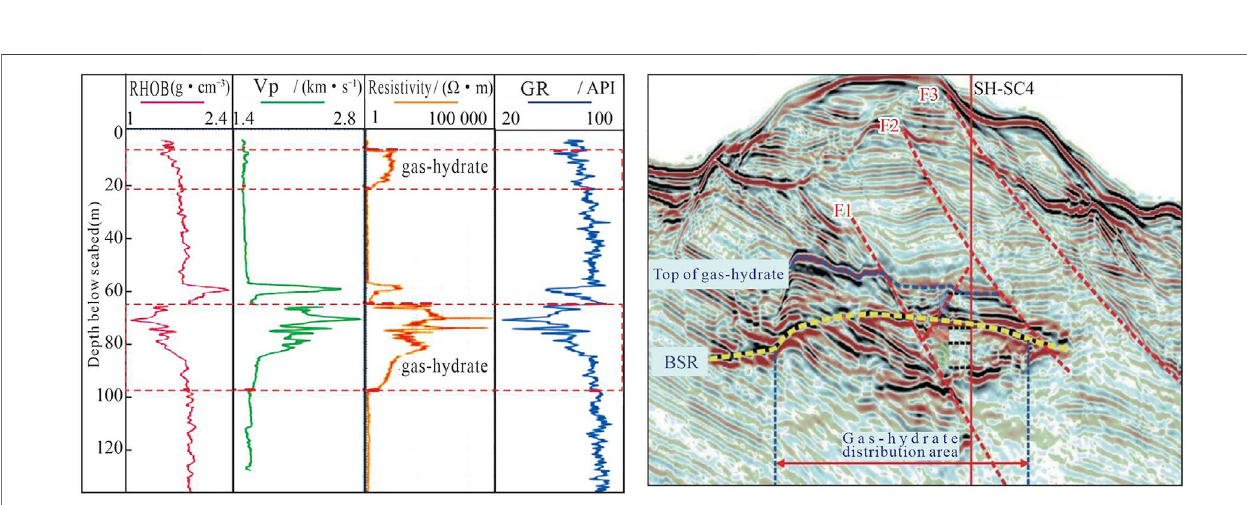
Frontiers in Earth Science |